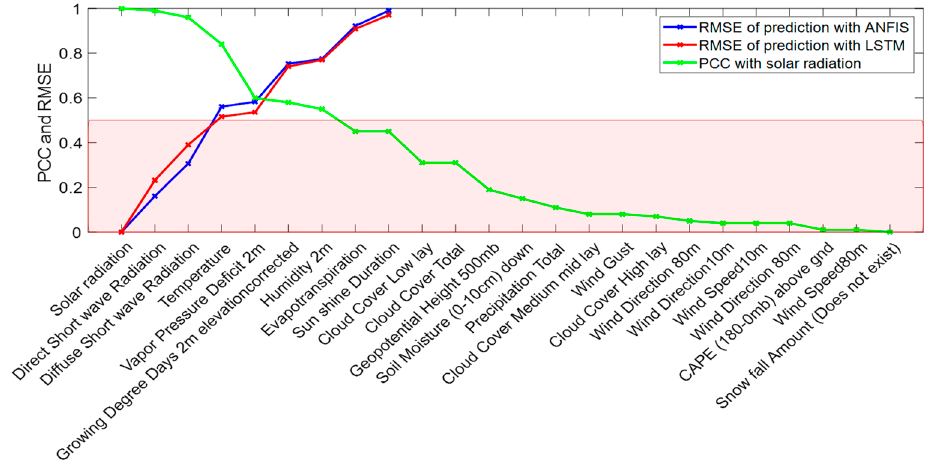
Figure 12. Spring season ranking between different meteorological parameters based on Pearson Correlation Coefficients and comparative performance of LSTM and ANFIS models with significant parameters selection (PCC ≥ 0.5) (dataset from 21 March 2021 to 20 June 2021).